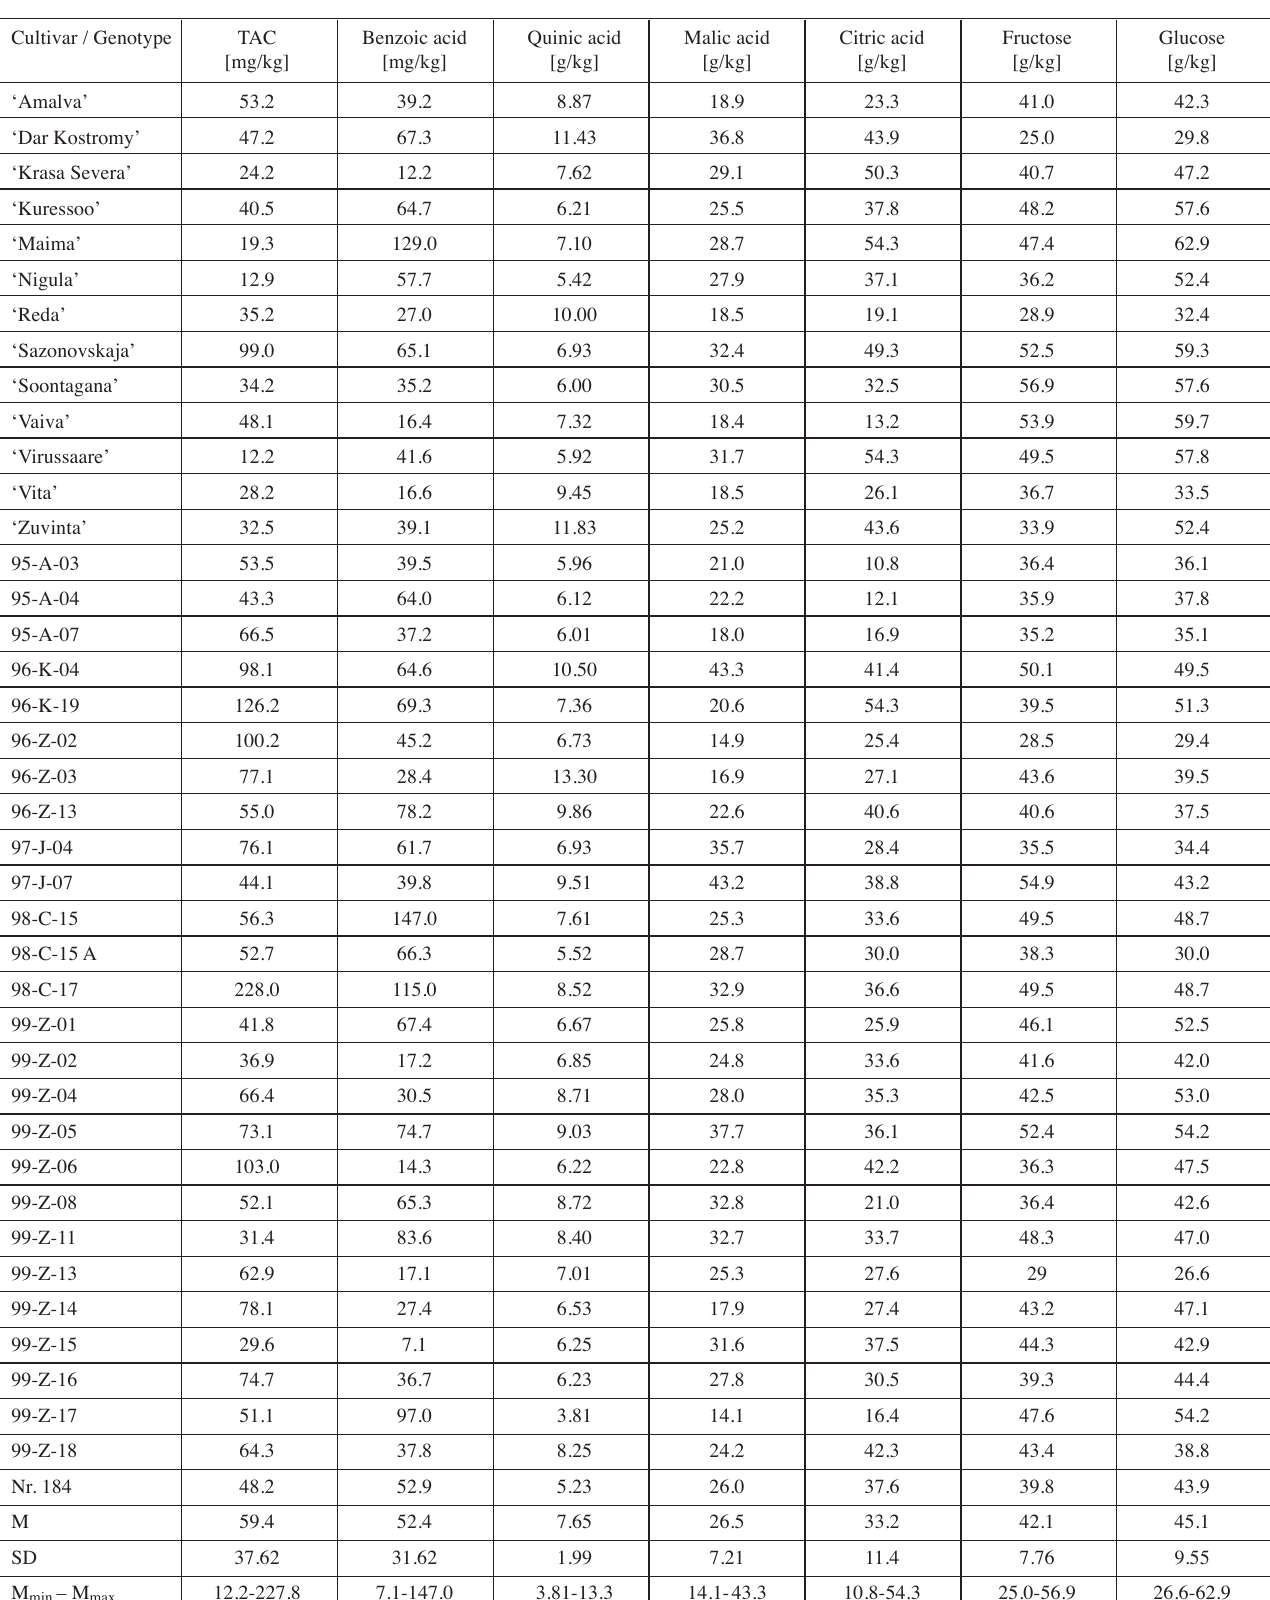
Tab. 1: Total anthocyanin (TAC), benzoic acid, quinic acid, malic acid, citric acid, fructose and glucose content in berry juice of 40 genotypes of Vaccinium